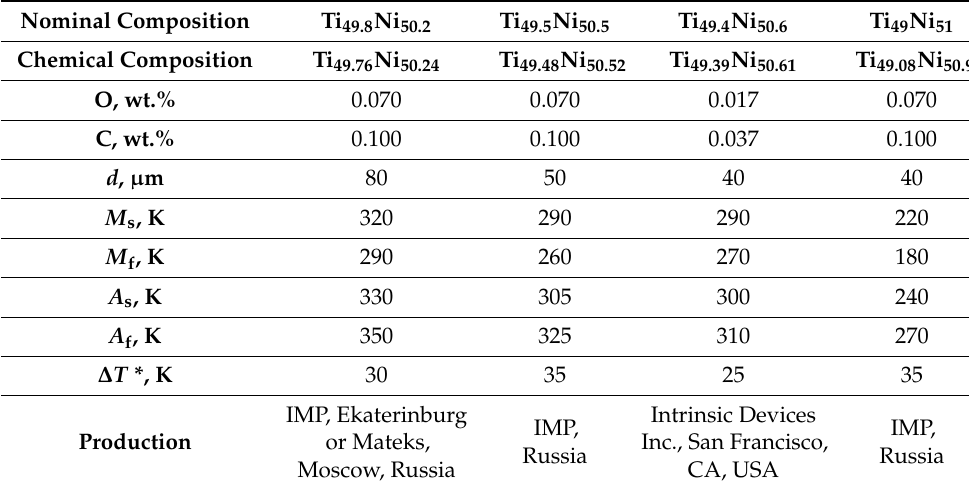
Table 1. Chemical composition, average grain size ( d ), and temperatures of forward ( M s , M f ) and reverse ( A s , A f ) TMTs, and hysteresis ( ∆ T ) of TMT of the studied hardened alloys. Nominal